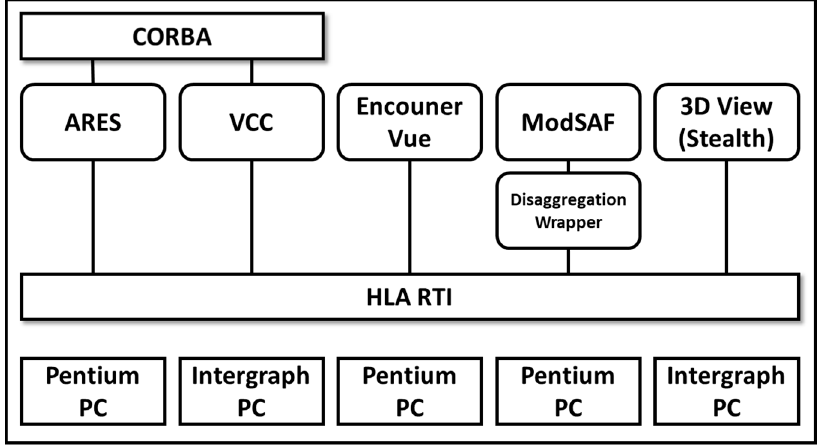
Figure 14. Battlespace federation of the ARES and ModSAF (adapted from [44]).